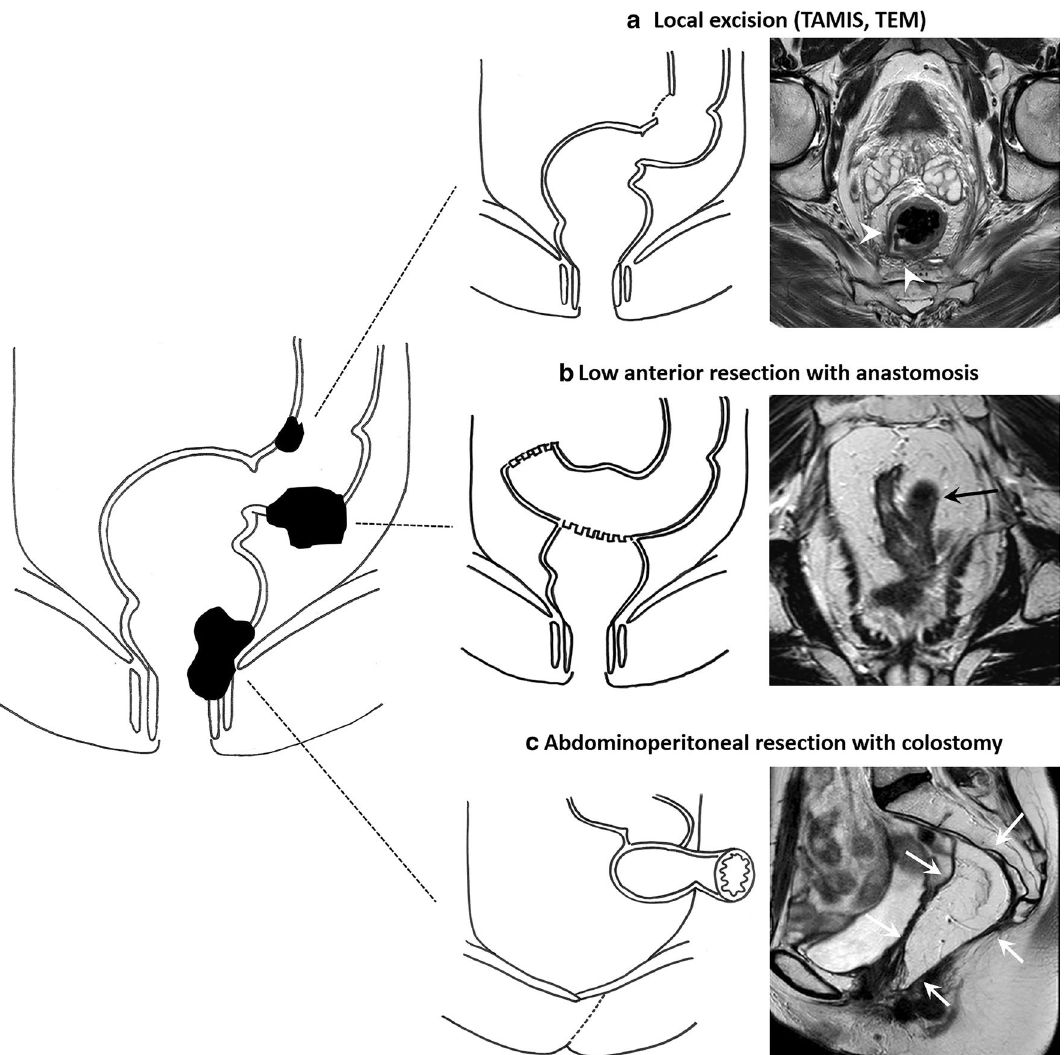
Fig. 14 Schematic illustration showing different surgical techniques used to resect rectal cancer, including their post‑operative appearance on MRI. With TAMIS and TEM ( a ), a full‑thickness resection of the tumour and the rectal wall results in a focal wall defect and surrounding fibrotic changes on post‑operative MRI (white arrowheads). After a low anterior resection ( b ), patients typically receive a ‘side‑to‑end’ anastomosis where the sidewall of the proximal colon loop is anastomosed to the end of the rectum stump, creating a small blind‑ending loop of the colon that can also be recognised on post‑operative MRI (black arrow). After an abdominoperineal resection, the rectum and anal canal are no longer in situ, and the patient receives a permanent colostomy. In this case, the post‑operative defect in the pelvis and pelvic floor was reconstructed with a myocutaneous rectus muscle flap (white